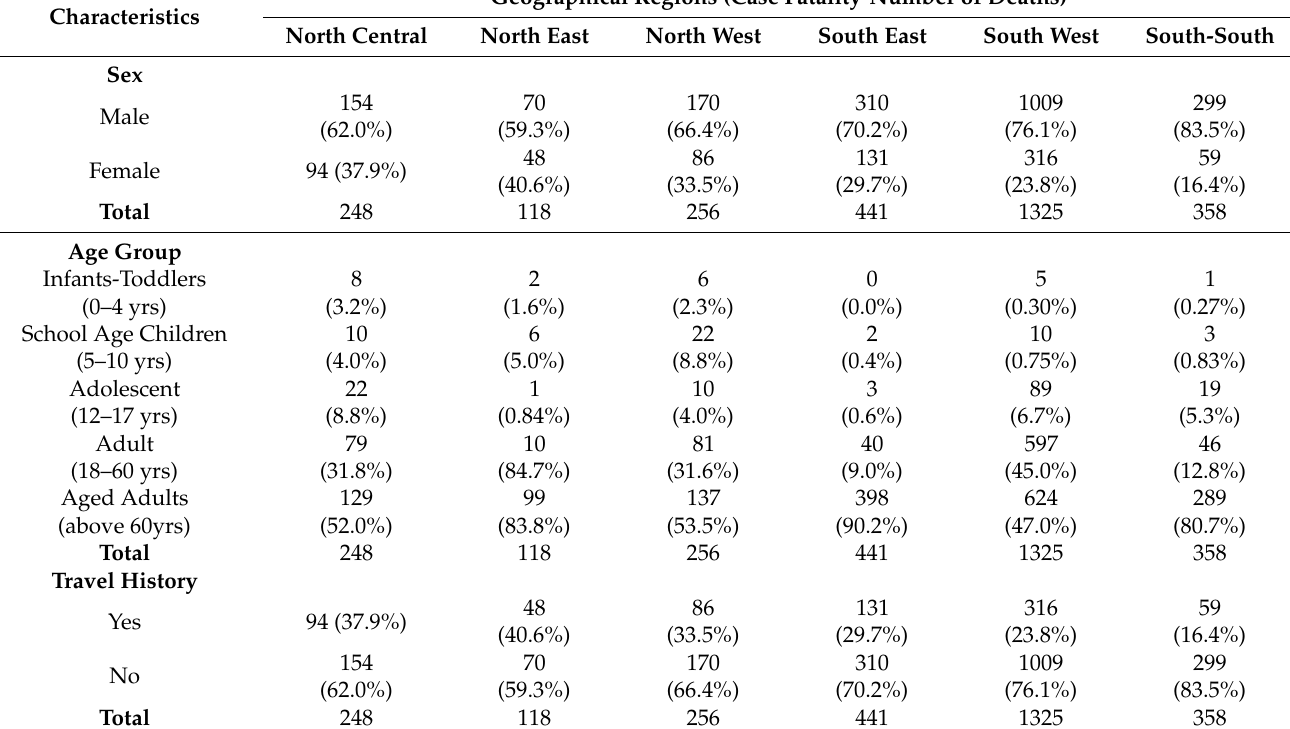
Table 5. Case Fatality (Number of deaths) of COVID-19 and Socio demographic Characteristics among geographical regions in